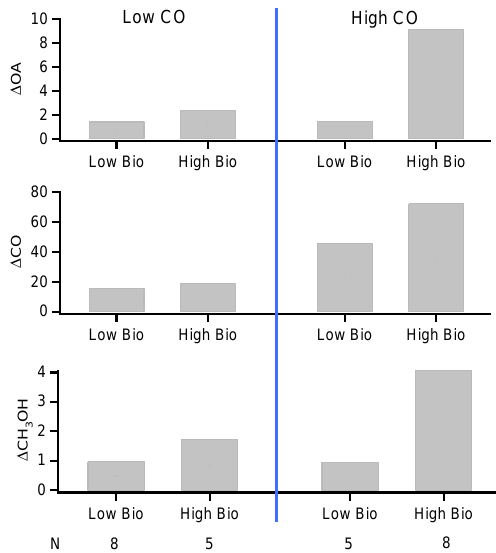
Figure 8. Values of (cid:49) OA, (cid:49) CO, and (cid:49) Isoprene for 4 subsets of transects. Pairs of bars labeled low CO and high CO have (cid:49) CO val- ues that are below the 33rd percentile and above the 67th percentile, respectively. Bars labeled low Bio and high Bio have (cid:49) Isoprene values that are below the 33rd percentile and above the 67th per- centile, respectively. Number of transects in each subset given at bottom. (cid:49) CO ratio and (cid:49) Bio ratio give effects of precursor mixing ratio on an A–B interaction relative to the expectation that (cid:49) OA is a bilinear function of (cid:49) CO, and (cid:49) Bio: (cid:49) CO ratio is ( (cid:49) CO: high CO, high Bio) / ( (cid:49) CO: high CO, low Bio). (cid:49) Bio ratio is ( (cid:49) Bio: high CO, high Bio) / ( (cid:49) Bio: high CO, low Bio).